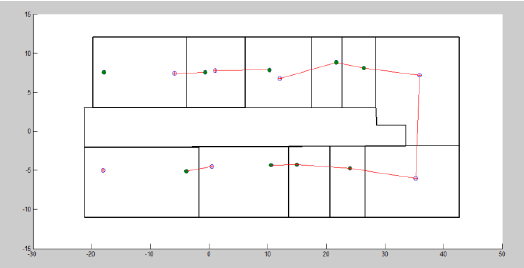
Figure 8. Test case 3 where surveying control points are represented as colored points and connection between dual nodes as red lines.